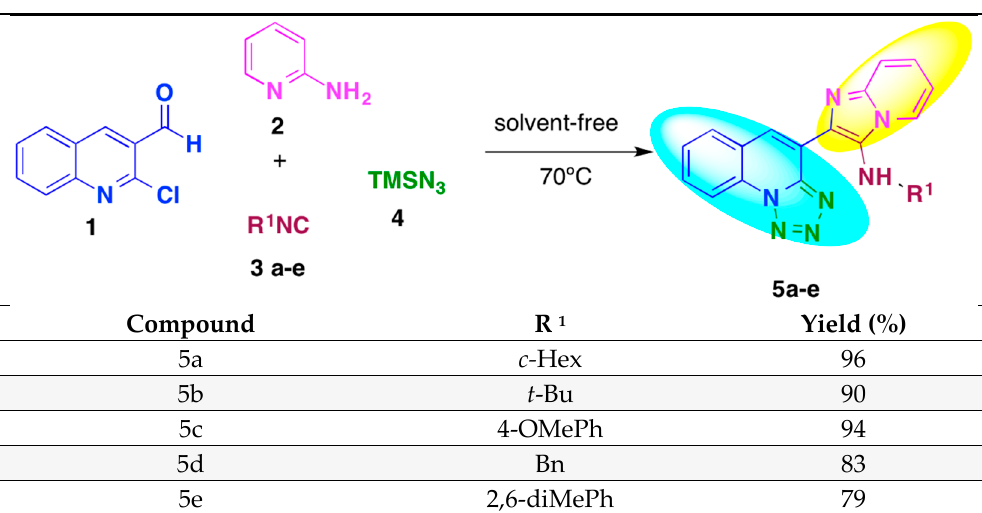
Table 2. Substrate